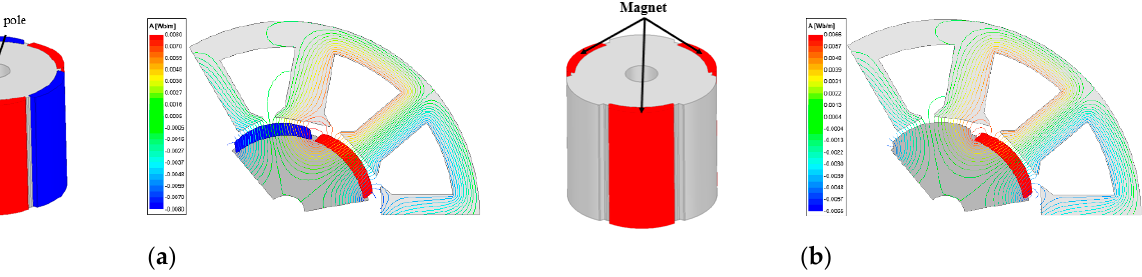
Figure 2. Rotor shape and magnetic flux line of existing model and consequent pole model: ( a ) con- ventional model, ( b ) consequent pole model.